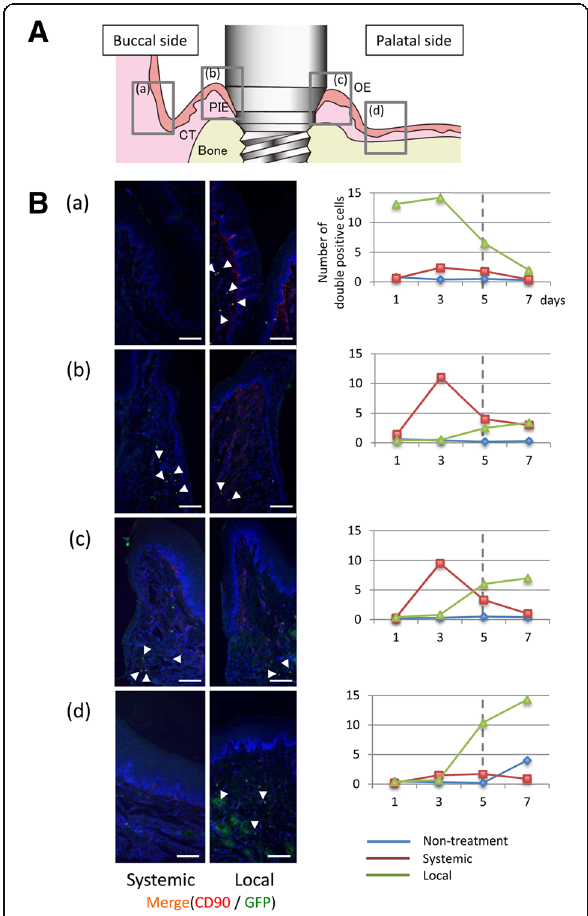
Fig. 5 MSC accumulation in the peri-implant tissue. A Schematic of the tissue structural arrangement around the implant. Gray squares indicates panels ( B , a) to ( B , d). B Immunofluorescence photos around the experimental implants. Right panels show a graphical representation of the results. CD90 (red staining)/GFP-FITC (green) double-positive cells were detected by immunostaining 5 days after each administration. Data are means ± SD of four independent experiments. * p < 0.05 (bar=200 μ m). (a) Alveololingual sulcus around the point of local administration. (b) Buccal side of peri-implant mucosa. (c) Palatal side of peri-implant mucosa. (d) Palatal